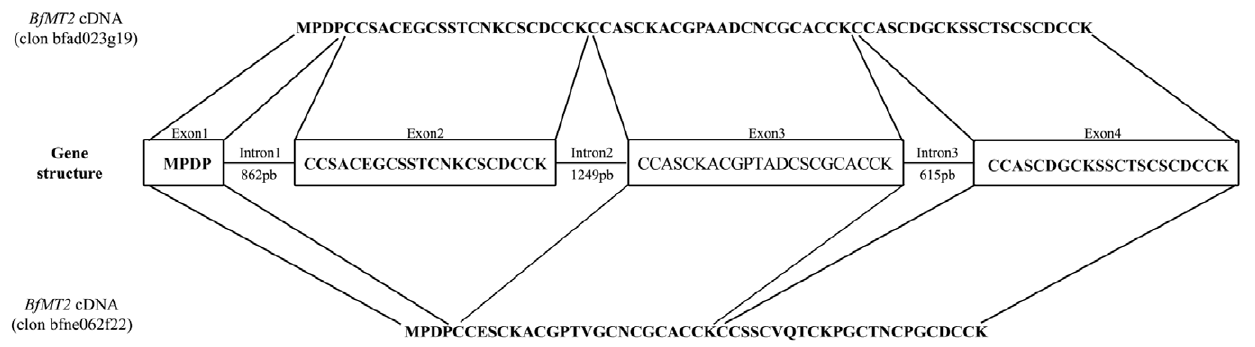
Figure 3. The analysis of the BfMT1 and BfMT2 genomic sequences identify all the elements of these genes. Promoter regions (-1 kb) are included and the in silico identified regulatory sequences (MRE and ARE) are highlighted in bold. 5 9 and 3 9 UTR regions, corresponding to the cDNA sequences of the cDNA clones, are included and represented in italics and underlined. Coding sequences are boxed in their corresponding exons and translated protein sequences are included below each exon.